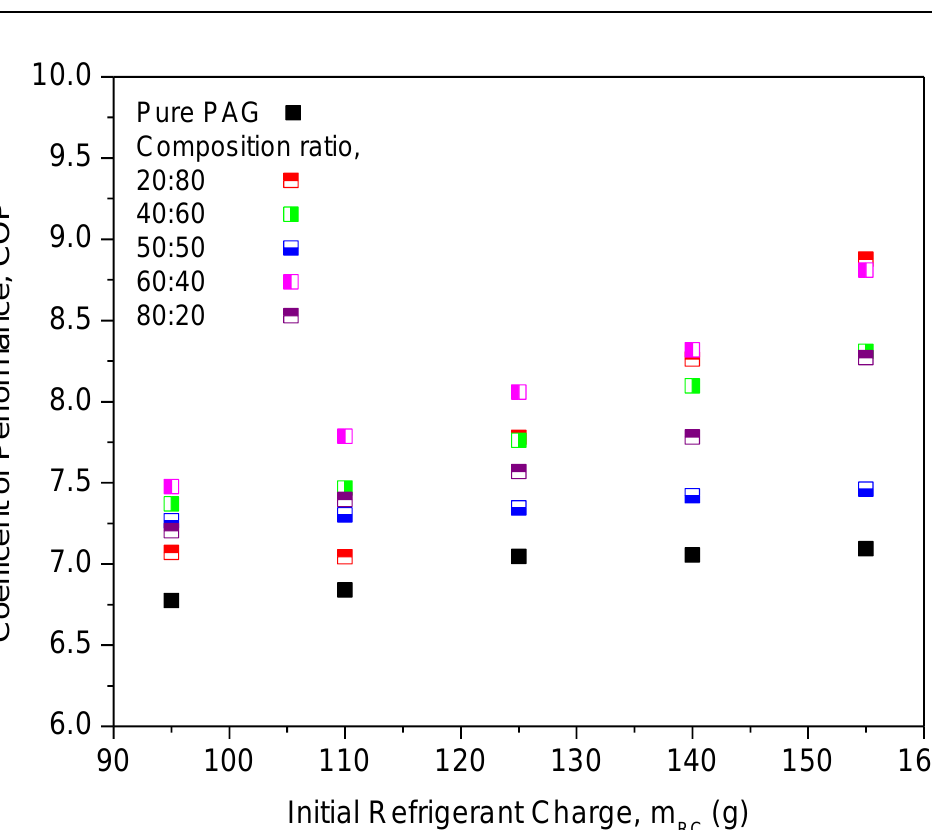
Figure 10. Compressor work of hybrid nanolubricants at various composition ratios.